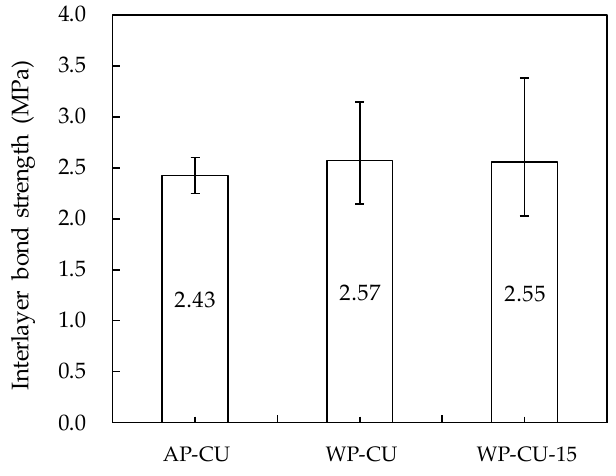
Figure 17. Interlayer bond strength.